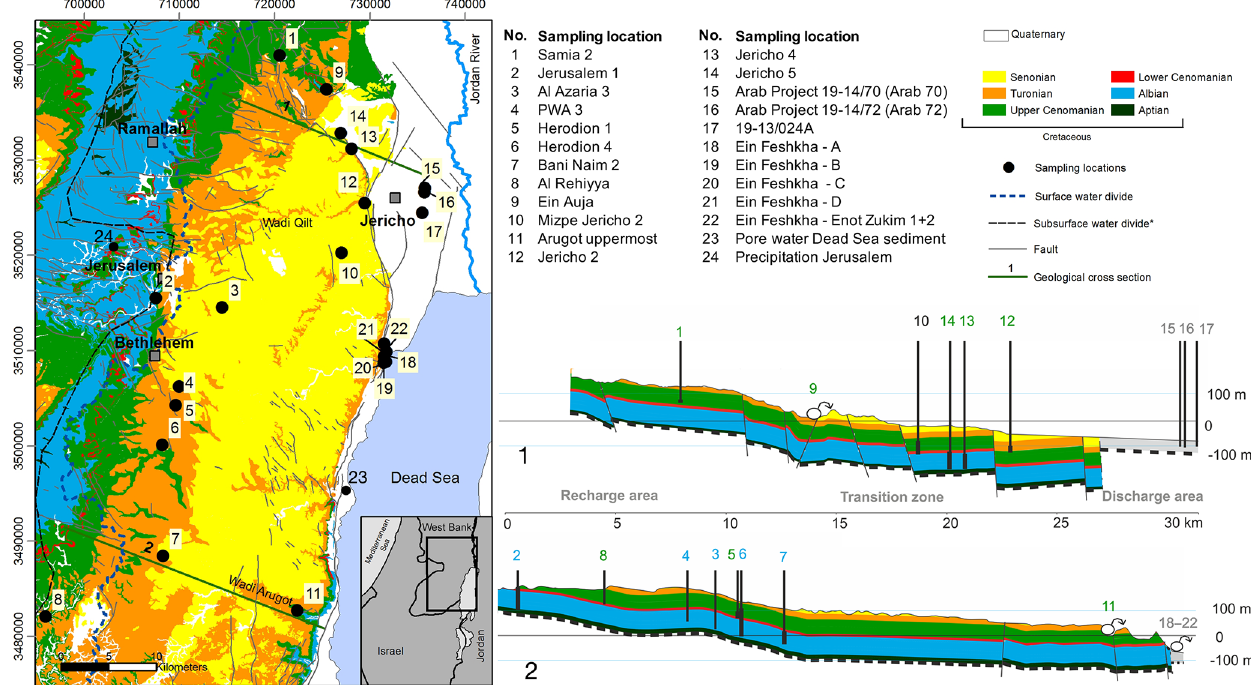
Figure 1. The location of the study site including geological information based on Begin (1974), Mor and Burg (2000), Raz (1986), Roth (1973), Shachnai (2000), Sneh and Avni (2011), and Sneh and Roth (2012). Universal Transverse Mercator (UTM) coordinates: UTM WGS84